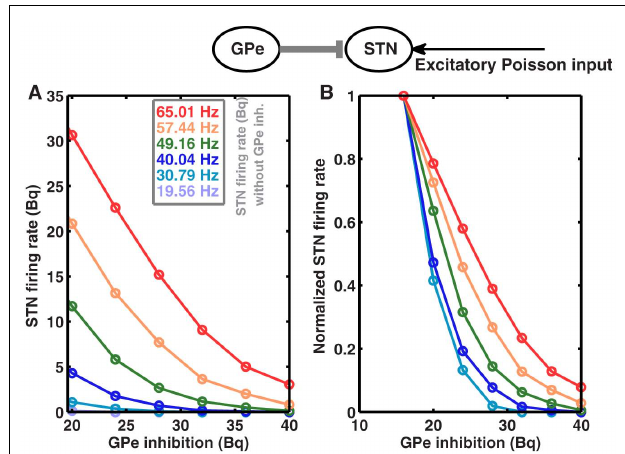
FIGURE 3 | GPe to STN coupling is not increased in high striatal output regime. Top Schematic of a single GPe and STN neuron coupled by a single inhibitory synapse. (A) Firing rate of an STN neuron as a function GPe inhibition, for different baseline firing rates in the STN. STN baseline firing rates were tuned to different by values by increasing the rate of input Poisson spike trains. Similarly, GPe spike trains were modeled as homogeneous Poisson process. (B) Same as in (A) , but normalized to the maximum firing rate for each STN baseline firing rates, to show the relative decrease in the STN activity as a function of increasing GPe inhibition.